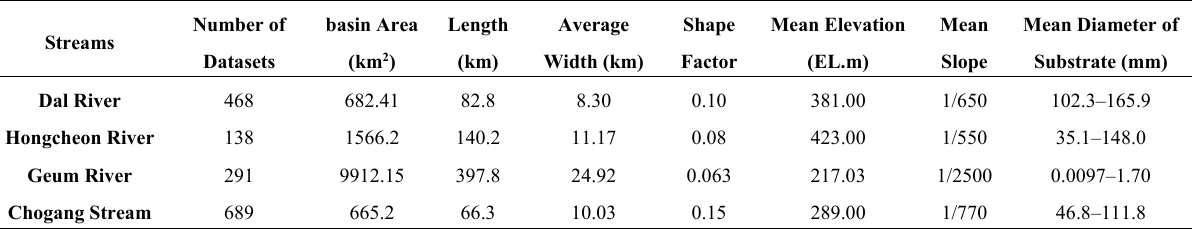
Table 1. Characteristics of the data used.